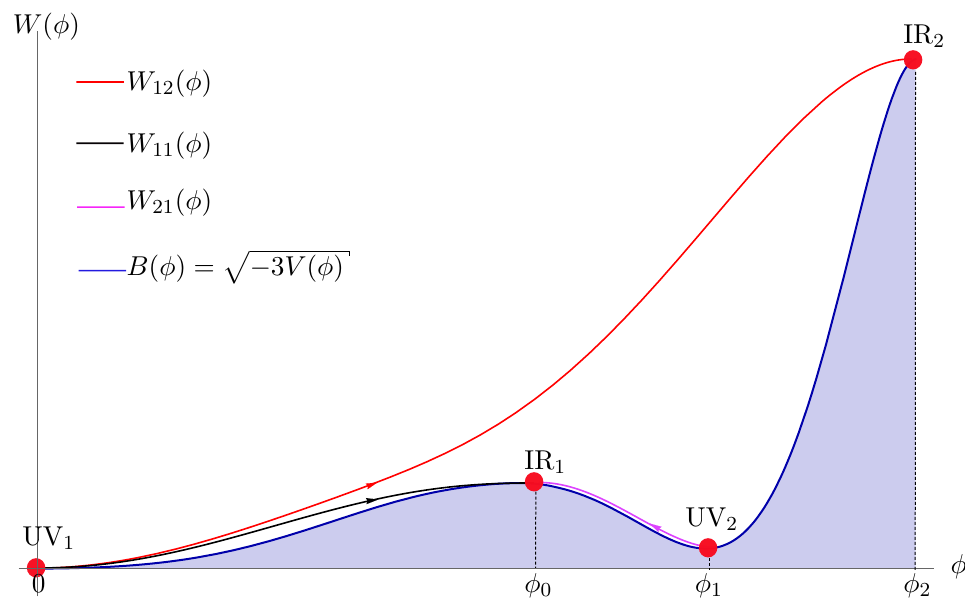
Figure 6 . The vacuum RG (cid:13)ow solutions arising from the potential (3.1). All (cid:13)ows interpo- late between one of the UV (cid:12)xed points and one of the IR (cid:12)xed points. The plotted lines are the superpotentials corresponding to each (cid:13)ow (see appendix A). The arrows represent the direc- tion of the (cid:13)ow from the UV to the IR. The blue area is the forbidden region below the curve p B ( (cid:30) ) = (cid:0) 4( d (cid:0) 1) V ( (cid:30) ) =d (where we set d = 4), which bounds from below any solution to the superpotential equation at T = 0 (as explained in appendix